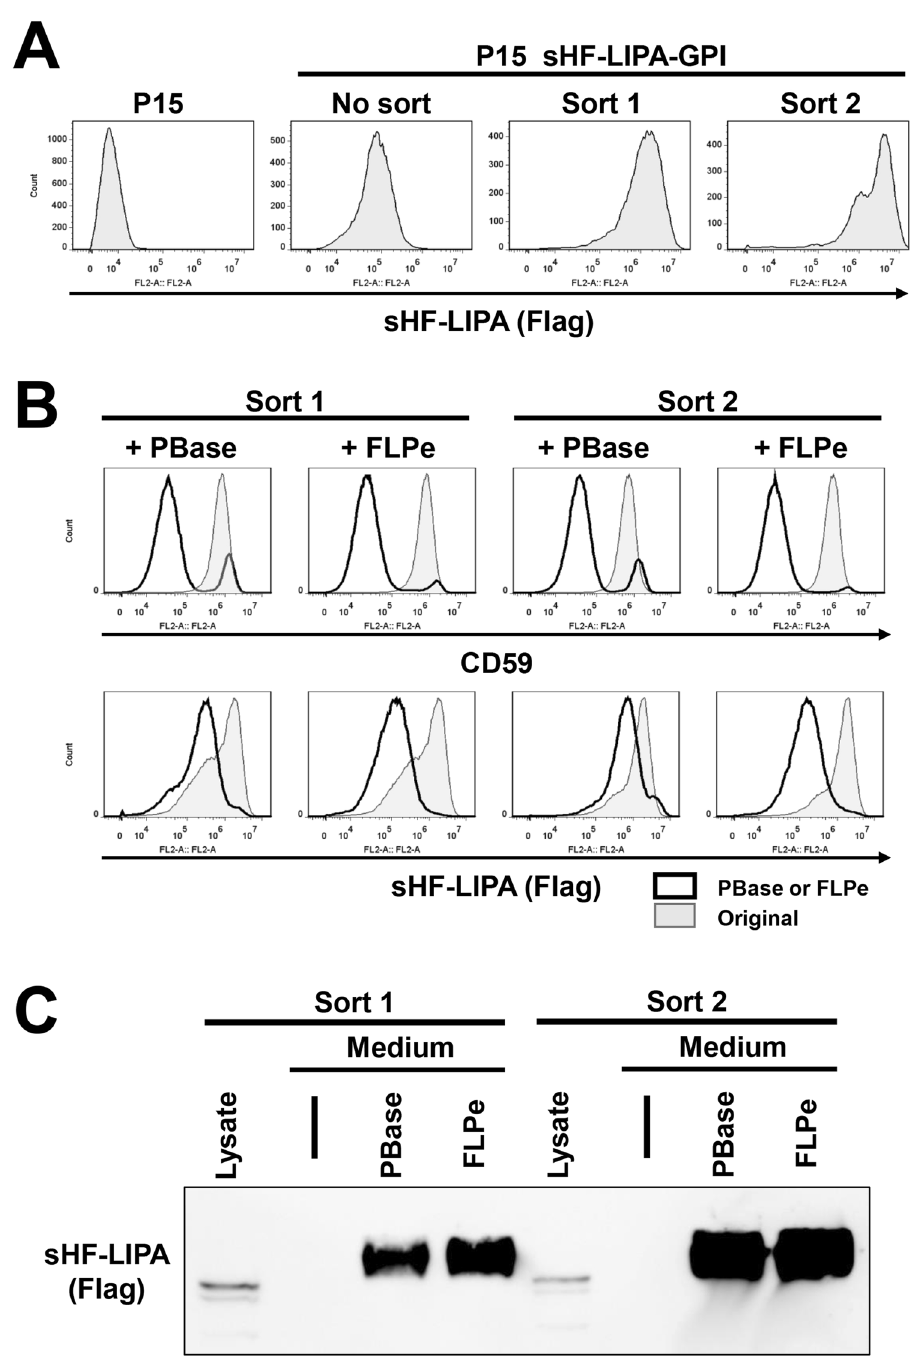
Figure 6. Enrichment of cells highly expressing LIPA. ( A ) Sorting of cells highly expressing sHF-LIPA-GPI. P15 cells stably expressing sHF-LIPA-GPI were sorted twice. Surface expression of sHF-LIPA-GPI was analysed by flow cytometry. Cells were stained with an anti-Flag antibody followed by a PE-conjugated goat anti-mouse IgG. ( B ) Sorted cells were transfected with the vector carrying PBase or FLPe recombinase. Expression of CD59 and sHF-LIPA-GPI on the cell surface was analysed. Original, P15 cells expressing sHF-LIPA-GPI after one round of sorting (Sort 1) and after two rounds of sorting (Sort 2). ( C ) sHF-LIPA in the cell lysate and culture medium was analysed. Culture medium from Sort 1 and Sort 2 cells with or without ( − ) treatment of PBase or FLPe recombinase were collected and precipitated. Proteins were detected by anti-Flag antibodies. The full image was included in the supplementary